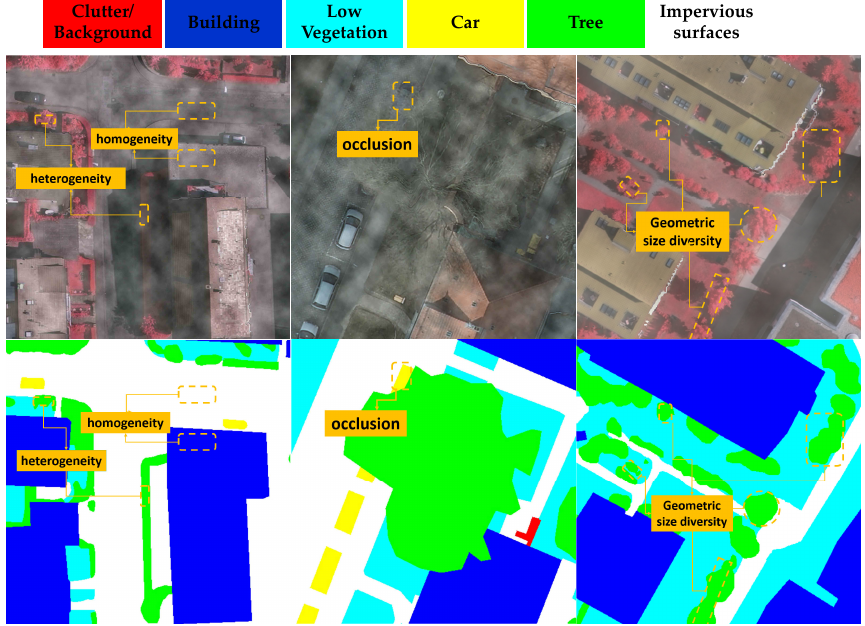
Figure 1. Challenges associated with robust LCC in the areas covered with fog. The first row is the fog corrupted image and the second row is the corresponding ground truth